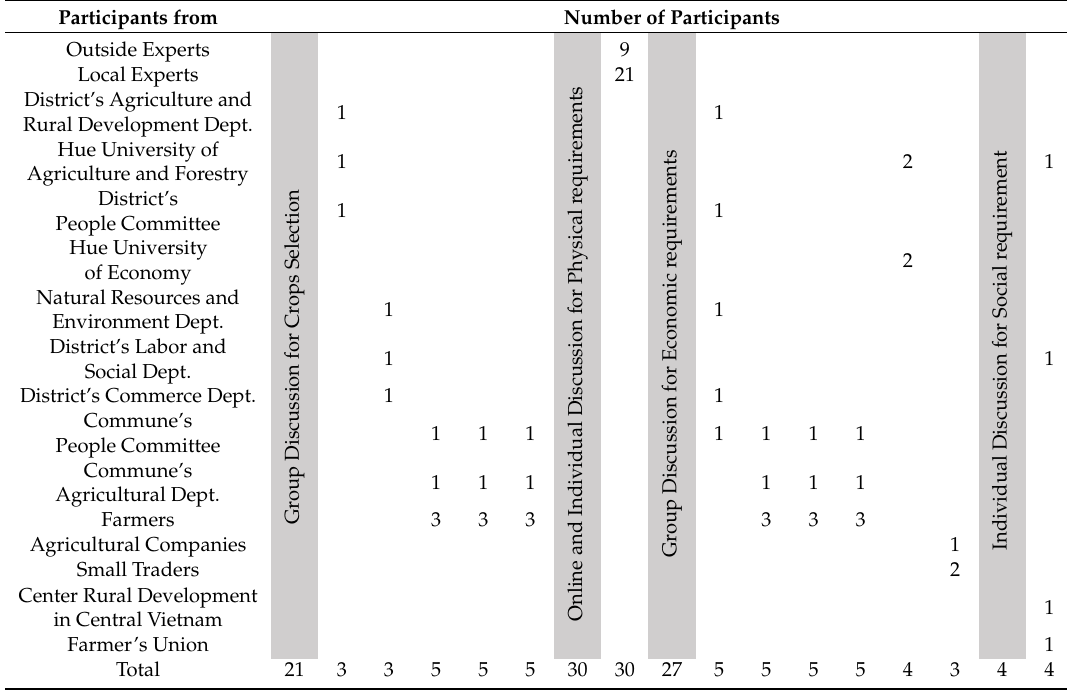
Table 2. Participants in Participatory Rural Appraisal (PRA)